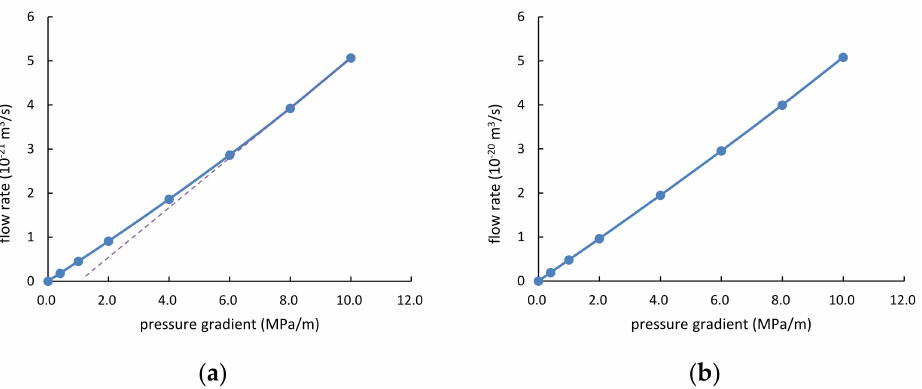
Figure 11. Comparison of flow rate between two models. ( a ) Rough wall model; ( b ) smooth wall